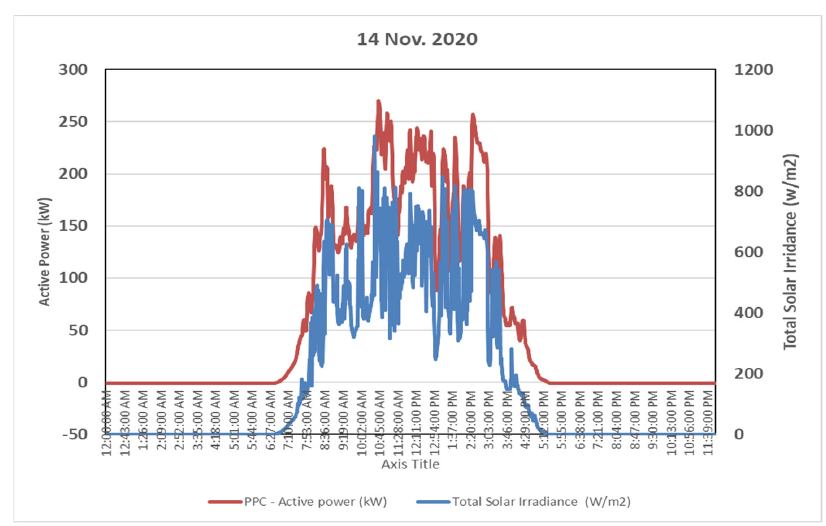
Figure 13. Power vs. irradiance on a moderately cloudy day.